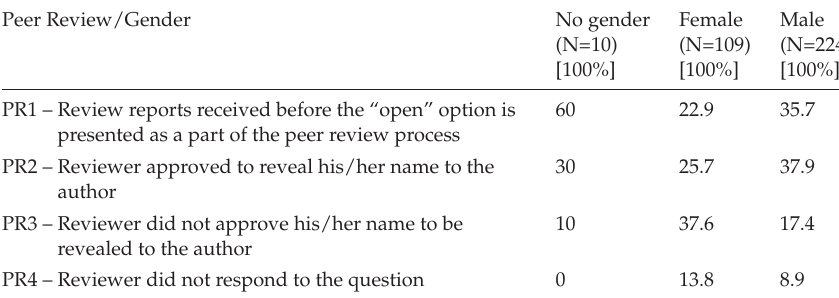
Table 10: Recommendations in the review reports and the gender [%].